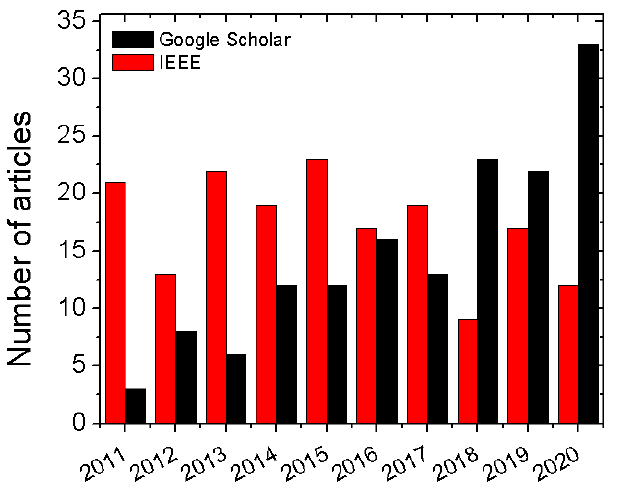
Figure 15. Number of relevant articles over the years as a search